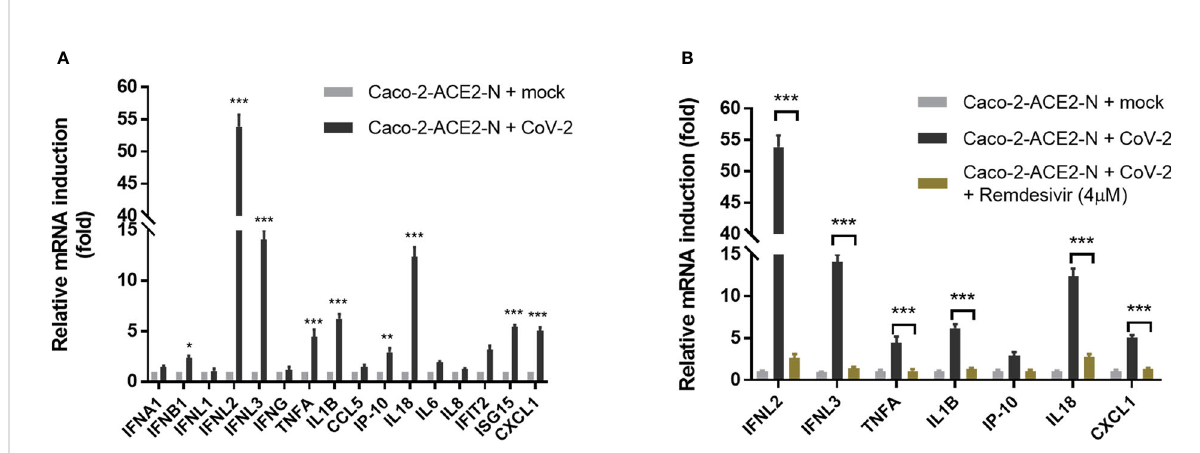
FIGURE 3 Immune response pro fi le of Caco-2-ACE2-N cells to SARS-CoV-2 GFP/ D N trVLP infection. (A) Caco-2-ACE2-N cells (2x10 5 ) were infected with SARS-CoV-2 GFP/ D N trVLP (CoV-2) with MOI = 0.25. At 48h post infection, mRNA induction of immune cytokines and chemokines response to CoV-2 infection was determined by qRT-PCR. Data were presented with fold change relative to mock infection. Four replicates were performed in the experiment. (B) With or without RNA replication inhibitor Remdesivir, the mRNA induction of immune cytokines and chemokines response to CoV-2 infection. Data are represented as mean ± SEM of four replicates. Statistical signi fi cance is indicated (*p<0.05, **p<0.01 ***p<0.001, unpaired t test).